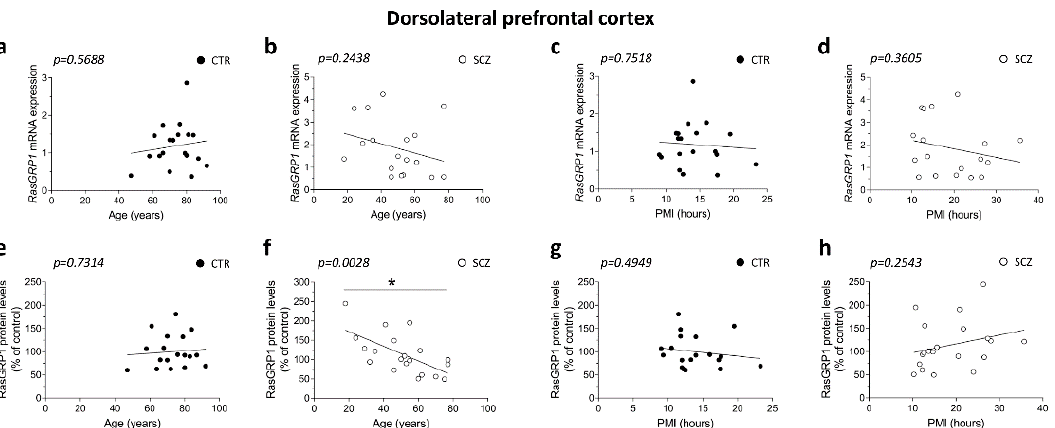
Figure 1. RasGRP1 protein levels negatively correlates with age but not with PMI in the DLPFC of schizophrenia patients. Analysis of correlation between age and mRNA/protein levels of RasGRP1 in the post-mortem DLPFC of ( a , e ) control subjects (CTR, n = 19) and ( b,f ) SCZ patients (SCZ, RasGRP1 mRNA: n = 18, RasGRP1 protein: n = 20). Analysis of correlation between PMI with mRNA and protein levels of RasGRP1 in the DLPFC of ( c , g ) control subjects (CTR, n = 19) and ( d , h ) SCZ patients (SCZ, RasGRP1 mRNA: n = 18, RasGRP1 protein: n =